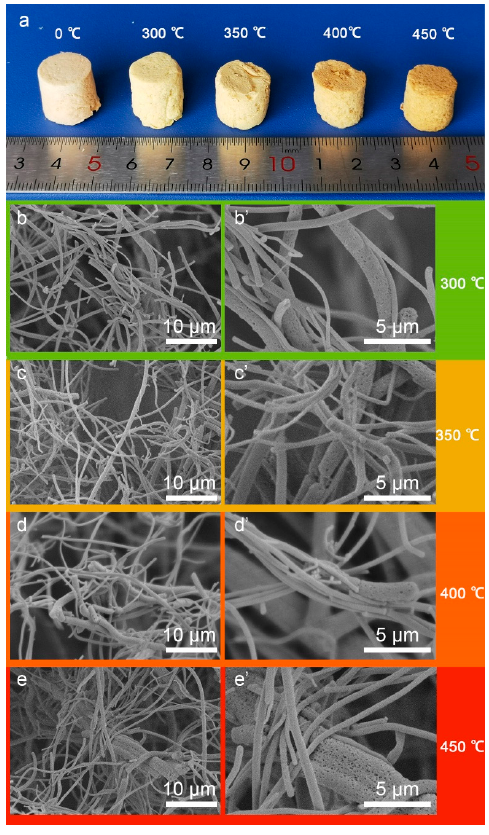
Figure 6. ( a ) Photograph and SEM images of PI/PTFE–PAI NAs at different sintering temperature as the ratios of PAA/PTFE–PAI@PEO was 5:5 and the content of fibers was 1%: ( b , b’ ) 300 °C; ( c , c’ ) 350 °C; ( d , d’ ) 400 °C; ( e , e’ ) 450 °C.